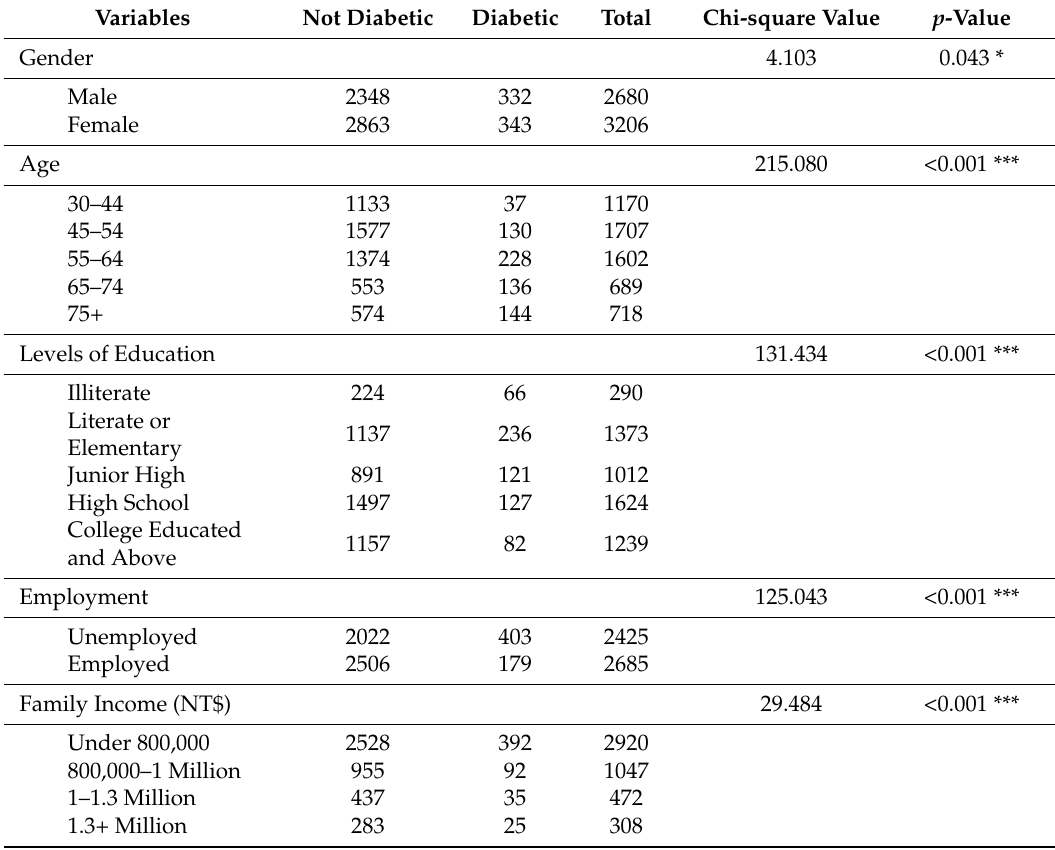
Table 1. Correlation of Each Demographic Variable and Having